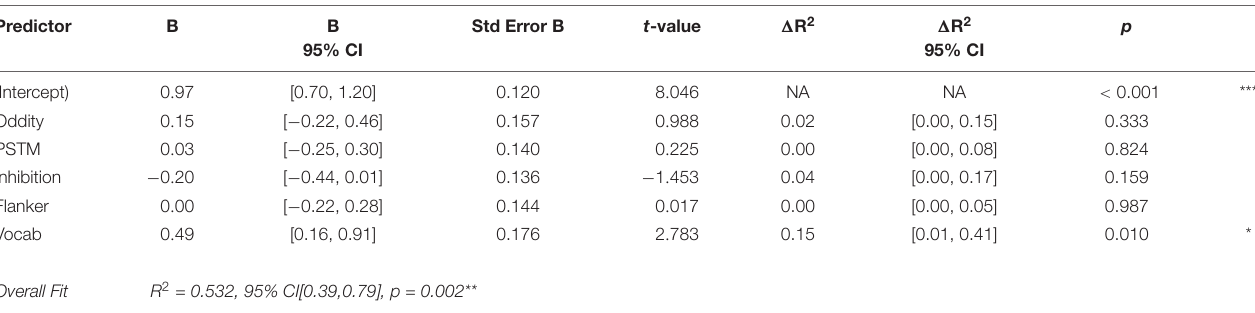
TABLE 6 | Summary of regression analysis for lexical decision,/tap-d/